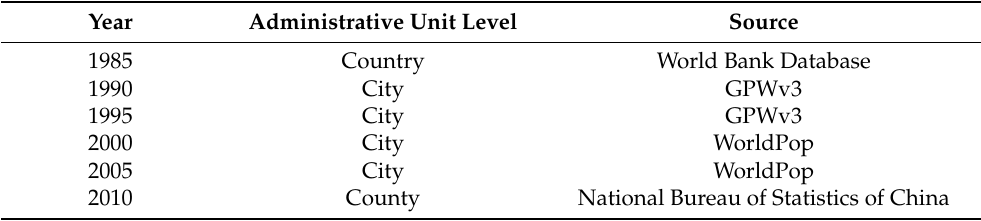
Figure A1. Illustration of how the input RS image evolves to the output population count in the ResNet-N by an example image patch. The activations of the first three and the last feature map of each network layer were visualized. The principal component analysis (PCA) dimension-reduction technique [77] was used to compress all feature maps of each layer to 3 RGB channels for visualization. It is shown that the shallow neural layers (Conv1 and Conv2) excavate concrete features such as texture, shape, and edge from natural landscapes. Then, the deep layers (Conv3, Conv4, and Conv5) extract informative abstract features based on the shallow features for population estimation. Table A1. Source and administrative unit level of census data or total population count for modifying raw population estimation of each